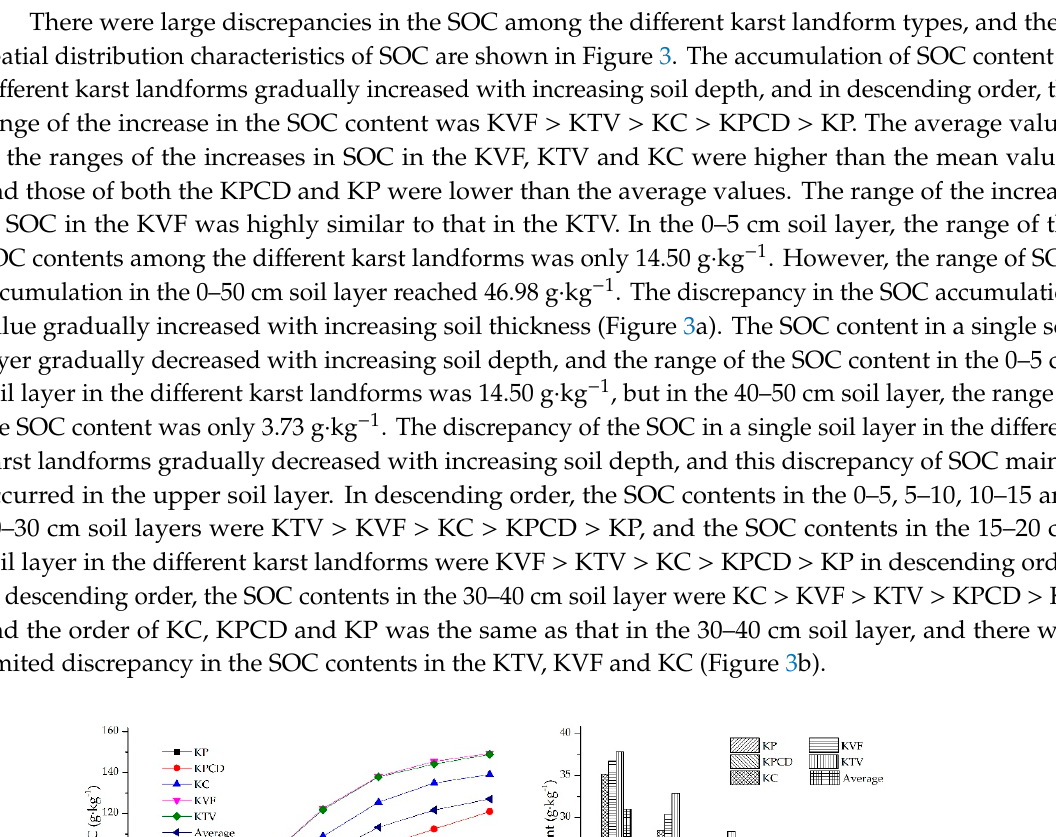
Table 1. Descriptive statistics of the soil organic carbon (SOC) content in soil horizons.